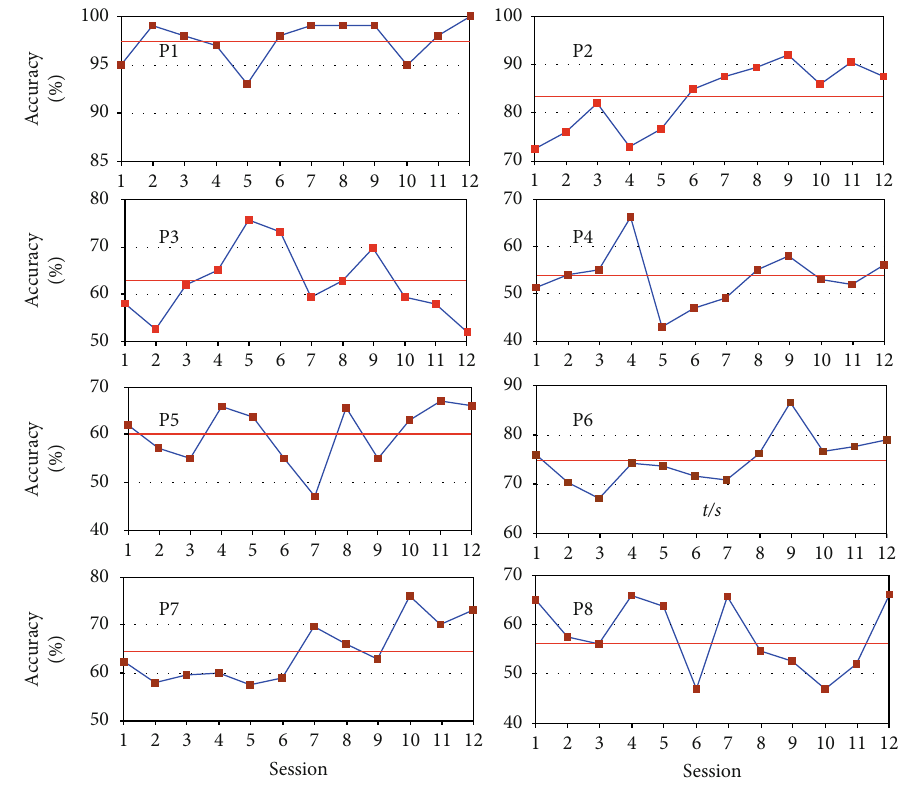
Figure 3: The accuracies across 12 sessions for all participants in the BCI group. The red line indicates the average accuracy. Table 2: FMA score comparison before and after rehabilitation training over the two